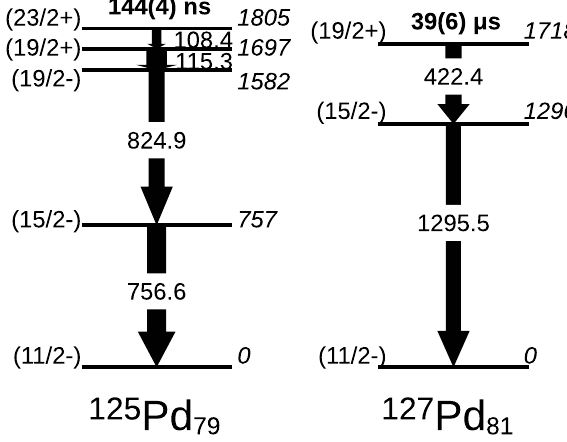
Figure 4. Level schemes of 125 Pd and 127 Pd established in Ref. [14]. Each level is labeled with the spin-parity ( J π ) and energy (relative to the 11 / 2 − state) values. The measured (iso- meric) half-lives are indicated in